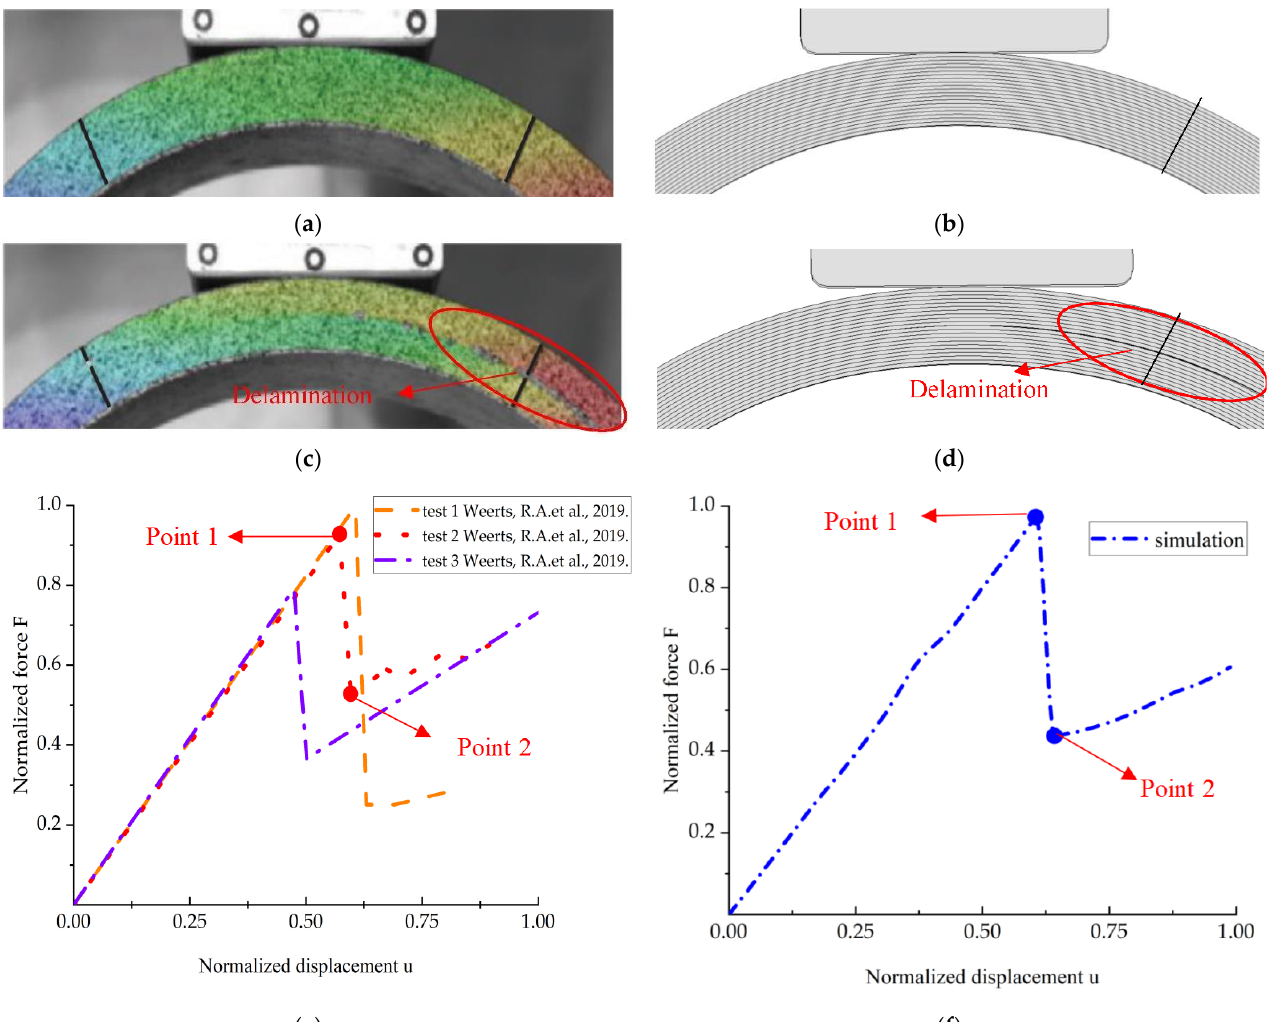
Figure 12. Experiment and simulation of the first delamination failure. ( a ) Experiment point 1 [9]; ( b ) simulation point 1; ( c ) experiment point 2 [9]; ( d ) simulation point 2; ( e ) force–displacement curves of experiment [9]; ( f ) force–displacement curve of simulation. Reprinted/adapted with permission from Ref. [9]. Life of current edition, Houcheng Fang, Di Wang.